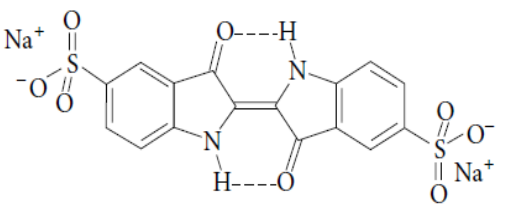
Fig. 1. Structure of Indigo carmen dye.